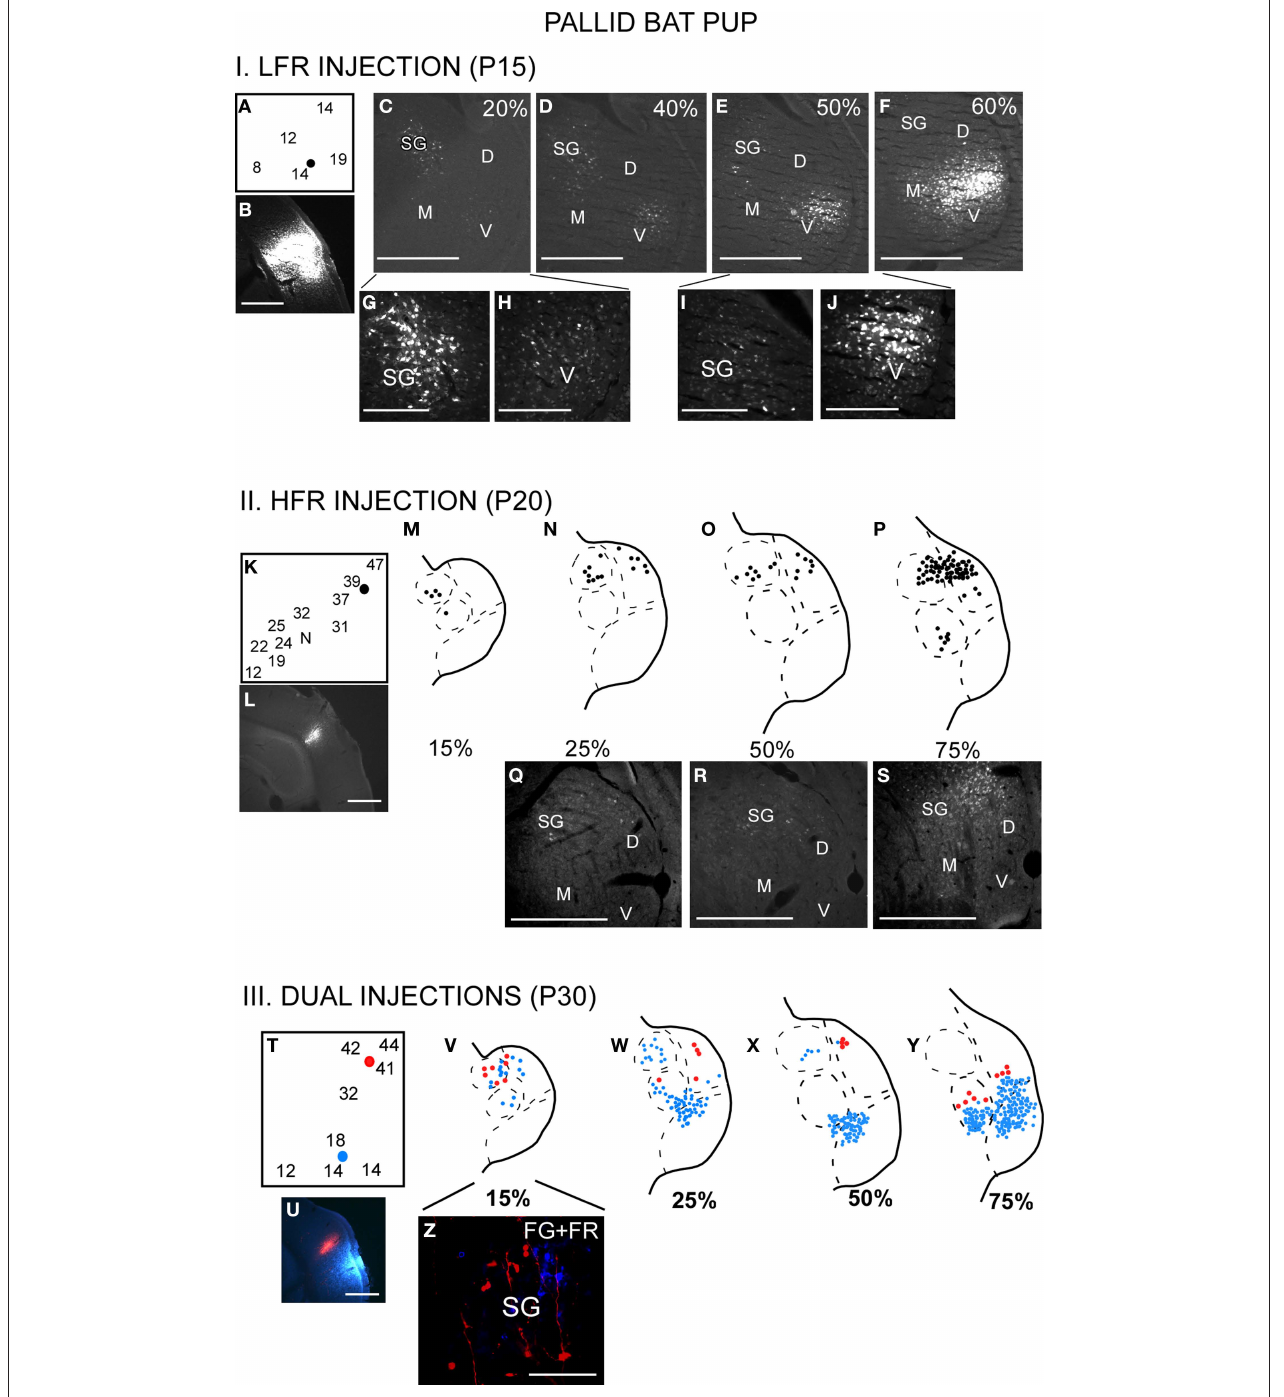
Figure 3 | The thalamocortical pathways overlap during early development. This occurs because the SG projects to both LFR and HFR in pups. I (A–J) LFR injection in a P15 pup. (A) FG was injected in the LFR near sites with tuning ∼ 15 kHz. (B) FG injection site. (C–F) Photomicrographs of increasingly rostral sections through the MGB demonstrate that both the SG and MGBv show labeled cells. (g,H) Magnified view of the SG and (i,J) MGBv show strong label in both areas. It can also be noted that caudal SG sends more projections to the LFR in pups than rostral SG. II (K–S) HFR injection in a P20